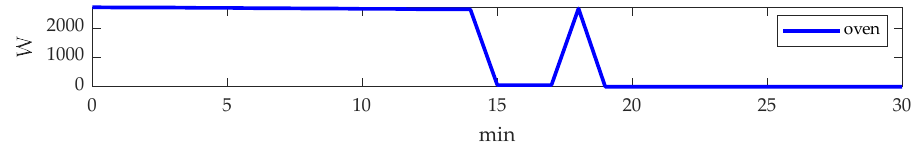
Figure 27. Simulation results.